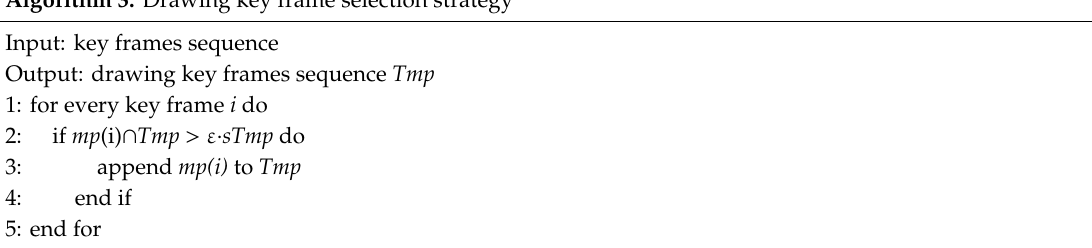
Algorithm 3. Drawing key frame selection